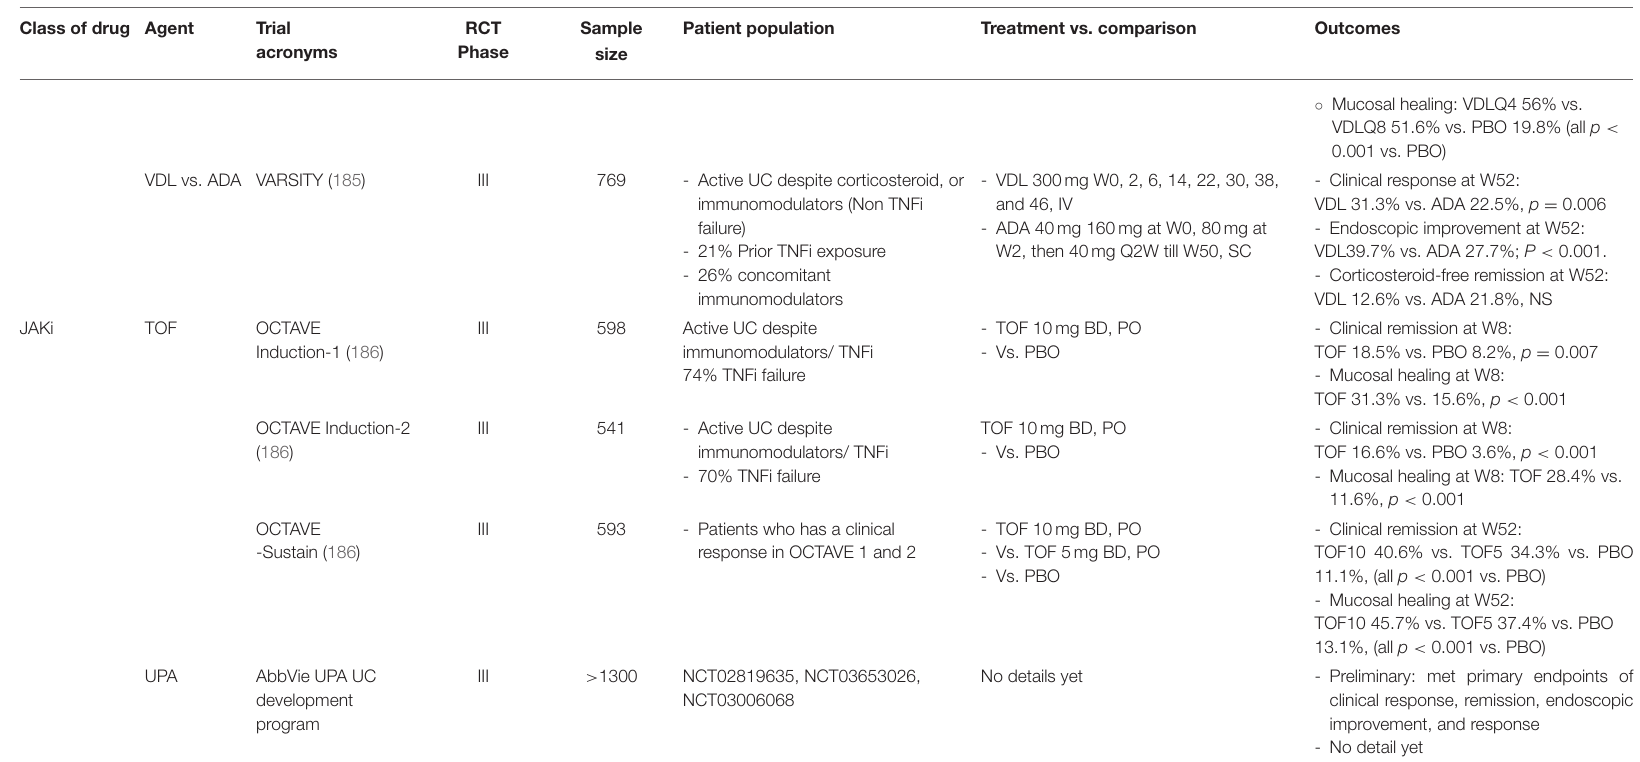
ADA, adalimumab; AS, ankylosing spondylitis; axSpA, axial spondyloarthritis; AZA, azathioprine; BD, twice daily; CI, confidence interval; CZP, certolizumab; GOL, golimumab; Gp, group; HR, hazard ratio; IFX, infliximab; IR, incidence rate ratio; IV, intravenous; JAKi, Janus kinase inhibitor; M, month; PO, per oral; Q, every; NS, not statistically significant; PBO, placebo; SC, subcutaneous; SEC, secukinumab; TNFi, tumor necrosis factor inhibitor; TOF, tofacitinib;